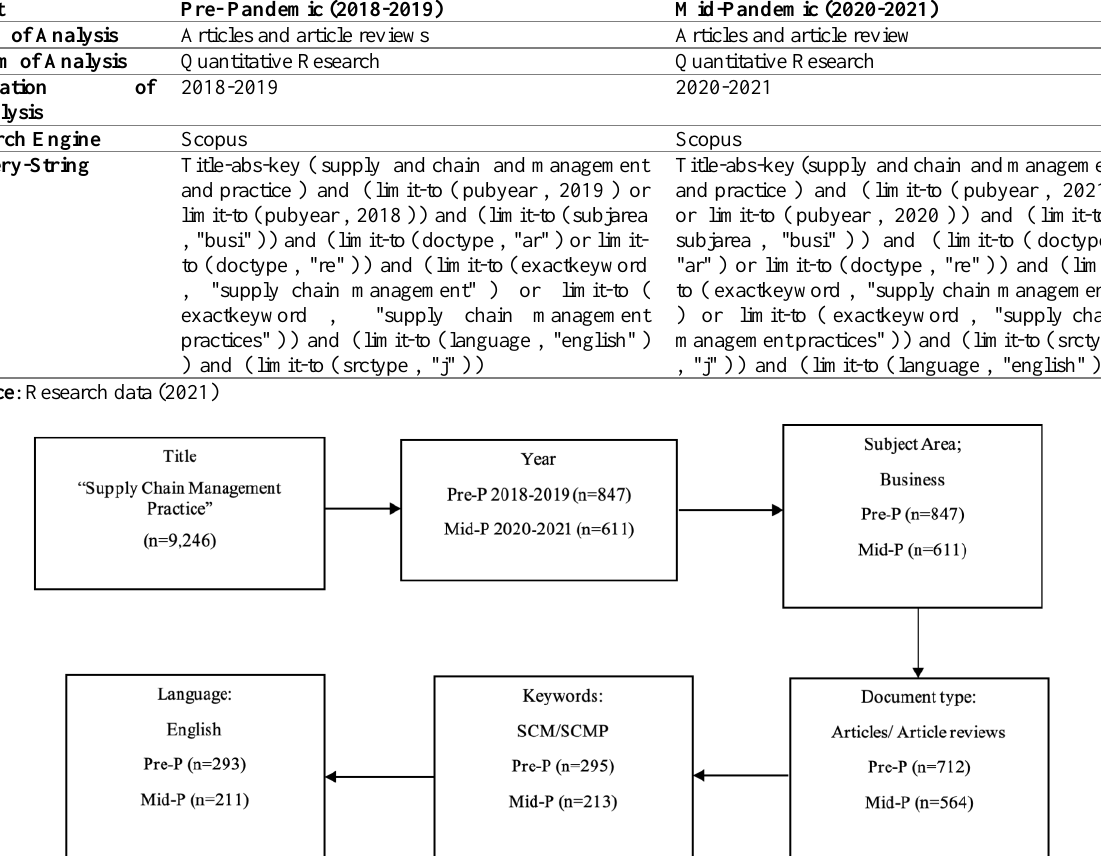
Table 1: Pre-Pandemic and Mid-Pandemic Methodology